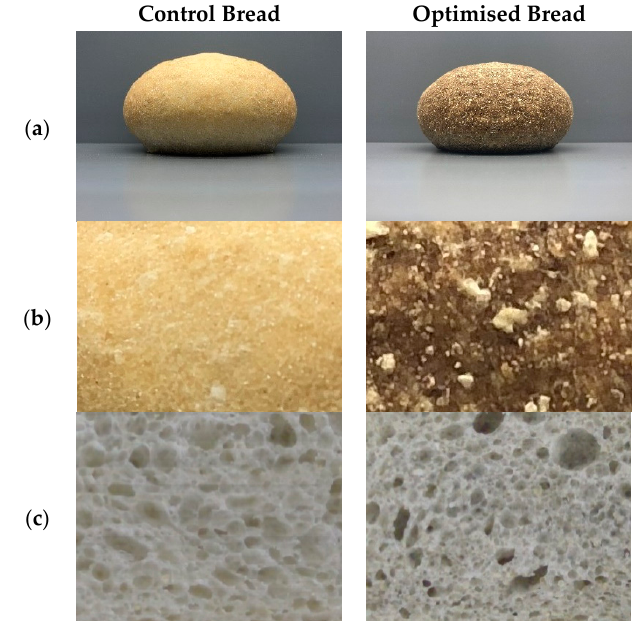
Figure 2. Photographic images of control bread and optimised bread: ( a ) bread roll, ( b ) crust, ( c ) crumb structure.